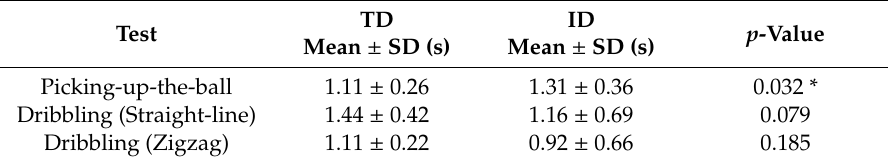
Figure 10. Results of T reaction . The participants with an intellectual disability (ID) had a slower reaction time only in the picking-up-the-ball test. Table 6. ANOVA results of the reaction time for the two groups in three